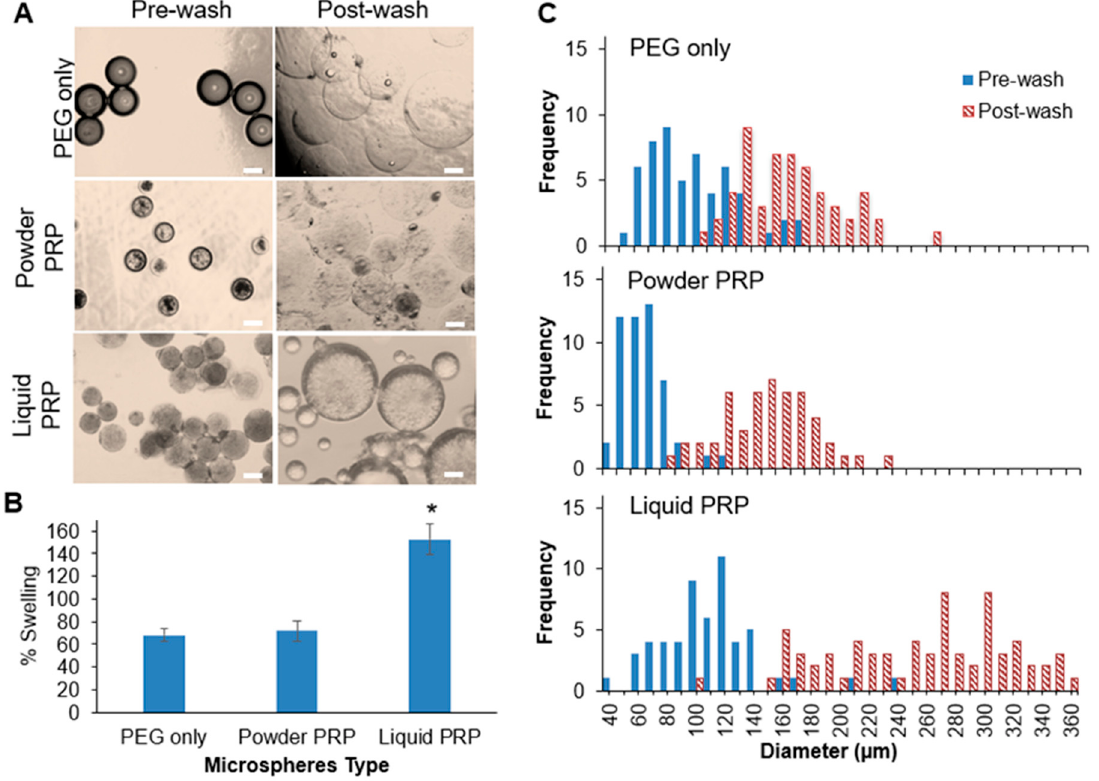
Figure 4. Swelling of PEG microspheres as a function of PRP loading. ( A ) Images of PEG-only, powder PRP, and liquid PRP-loaded microspheres before and after swelling. Scale bar is 100 µm. ( B ) Percent swelling of PEG-only, powder PRP, and liquid PRP-loaded microspheres * indicates statistical difference from all other conditions (n = 50; p < 0.05). ( C ) Representative histograms for the size distribution of one batch of fabricated microspheres of PEG-only, powder PRP, and liquid PRP. Microspheres were prepared with 4-arm PEG–Ac and PEG–diSH as a crosslinker at 10% w/v in PEG. Powder and liquid PRP were loaded at 10% w/v.